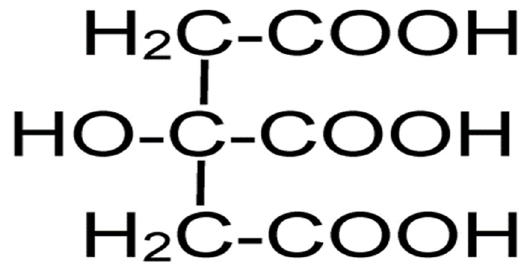
Figure 1. The structure of citric acid.